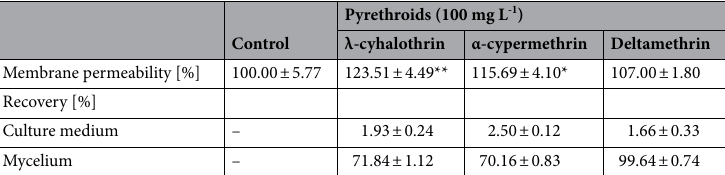
Table 4. Membrane permeability and accumulation of pyrethroids in the B. bassiana cells. Data are means ± SD; all samples were prepared in triplicate, and the experiments were repeated twice. Results were tested by one-way ANOVA; significance: ** P < 0.01, * P <